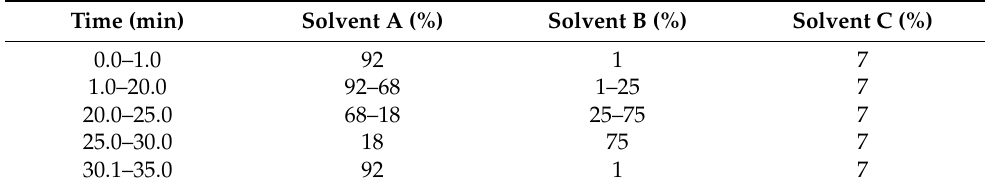
Table 4. The optimized elution profile for quantitative analysis of polyphenols in the flowers of A. hippocastanum